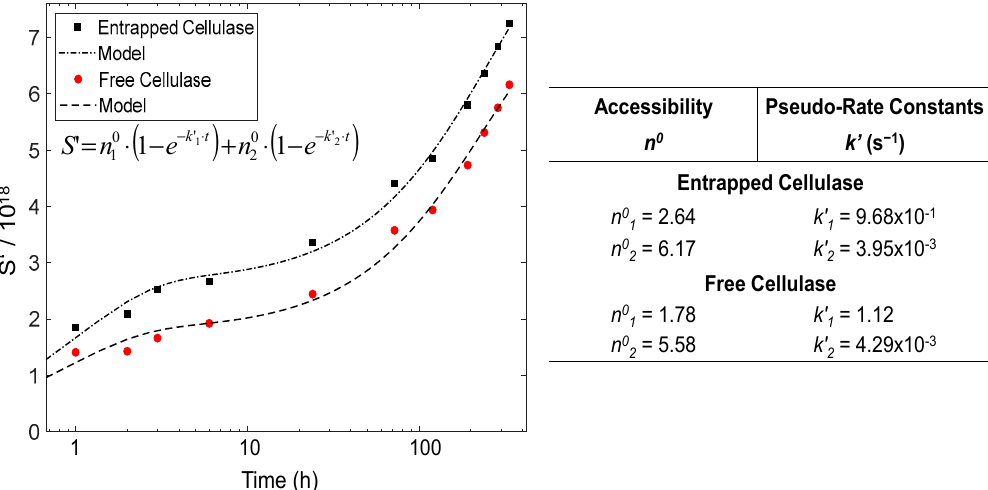
Figure 10. Evolution of the fraction of hydrolyzed glycosidic bonds S’ with the hydrolysis time during the enzymatic degradation of CNFs by the entrapped cellulase in comparison to the free enzyme. Table on the right displays the accessibility n 0 and pseudo-rate constant k’ values obtained for the hydrolysis of CNFs by the entrapped and the free cellulase, by modeling the experimental data with the sum of parallel first-order kinetics in the regimes 1 and 2 (Equation (6)).